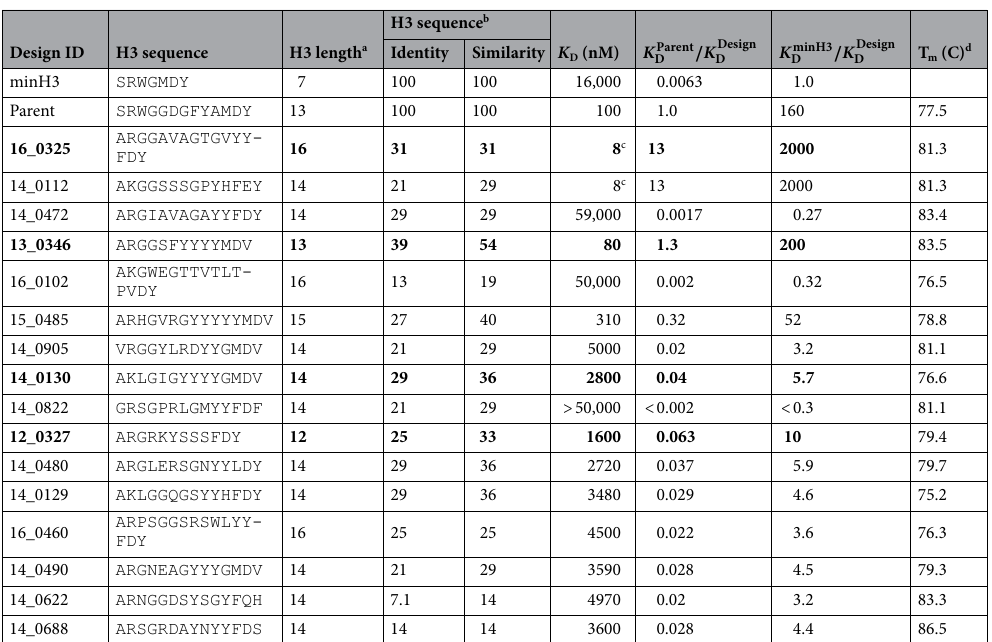
Table 2. Selected H3 sequences for experimental validations. a Loop sequence length, in amino-acid residues, according to the IGMT definition 46 . b H3 sequence identity and similarity relative to the parental H3 sequence as determined using MOE (Chemical Computing Group) alignment tools. Highlighted in bold are the designs structurally characterized by X-ray crystallography. c Poor fit to 1:1 Langmuir binding model. d See DSC thermograms (Figure